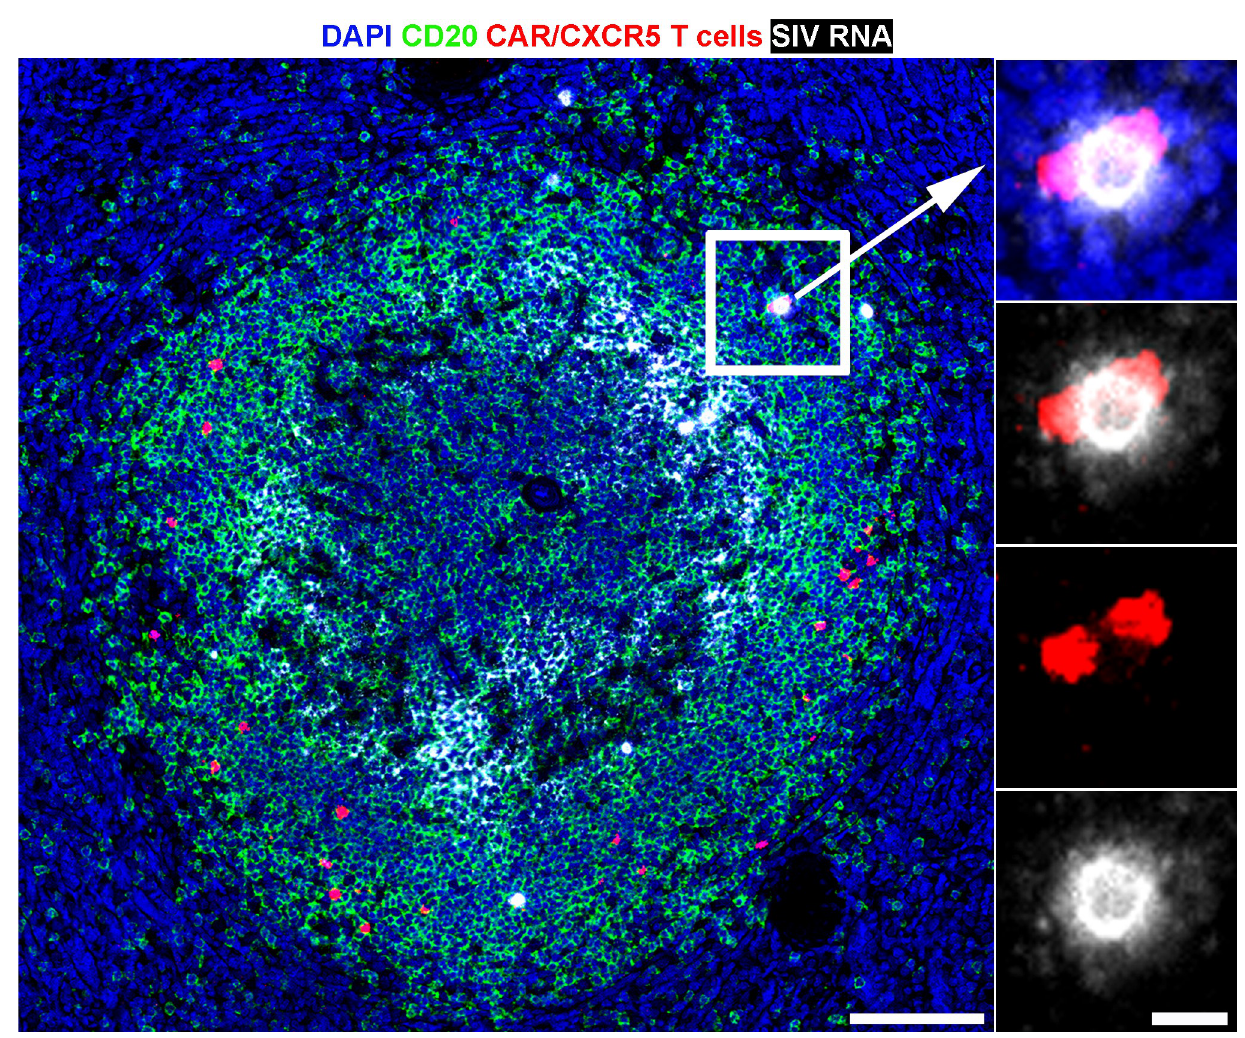
Fig 2. CAR/CXCR5-T cells home to lymphoid follicles and recognize SIV-infected cells in vivo. Location of CAR/CXCR5-T cells (red) within lymphoid tissues was determined in a chronically SIV-infected ART-na ï ve rhesus macaque, animal R14025 at 2 days post-treatment (DPT). Representative image of spleen tissue section showing duplex detection of CAR/CXCR5 construct (red) and SIV (pseudo-colored white) using RNAscope ISH combined with immunofluorescence using a custom-made probe for detection of CAR/CXCR5 construct and a probe specific for SIV. The white haze within the B cell follicle represents SIV virions trapped by the follicular dendritic cells (FDC) network. Scale bar = 100 μ m. The right panels are enlargements showing an interaction between two CAR/CXCR5-transduced T cells and an SIV-infected cell. The tissue was stained with DAPI (blue), and anti-CD20 (green) to label B cells and delineate B cell follicles. Scale bar = 10 μ m. Confocal images were collected using a 20 × objective. The curves tool in Photoshop was used to increase the contrast of each image in a similar manner.